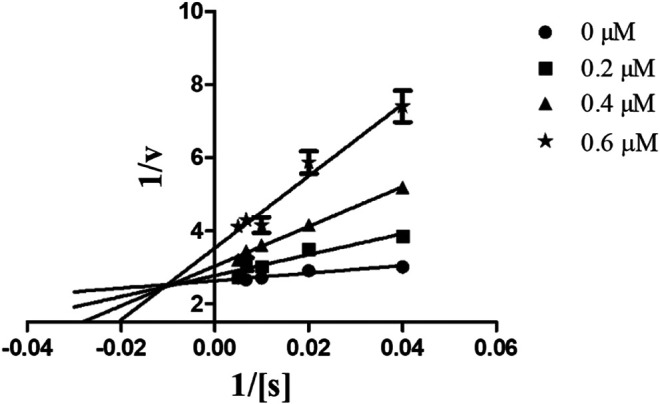
Lineweaver-Burk Plot for h-NTPDase3 inhibitor (8m). S represents the substrate concentration (μM) and concentration of inhibitor (8m) are 0, 0.20, 0.4, and 0.6 μM.